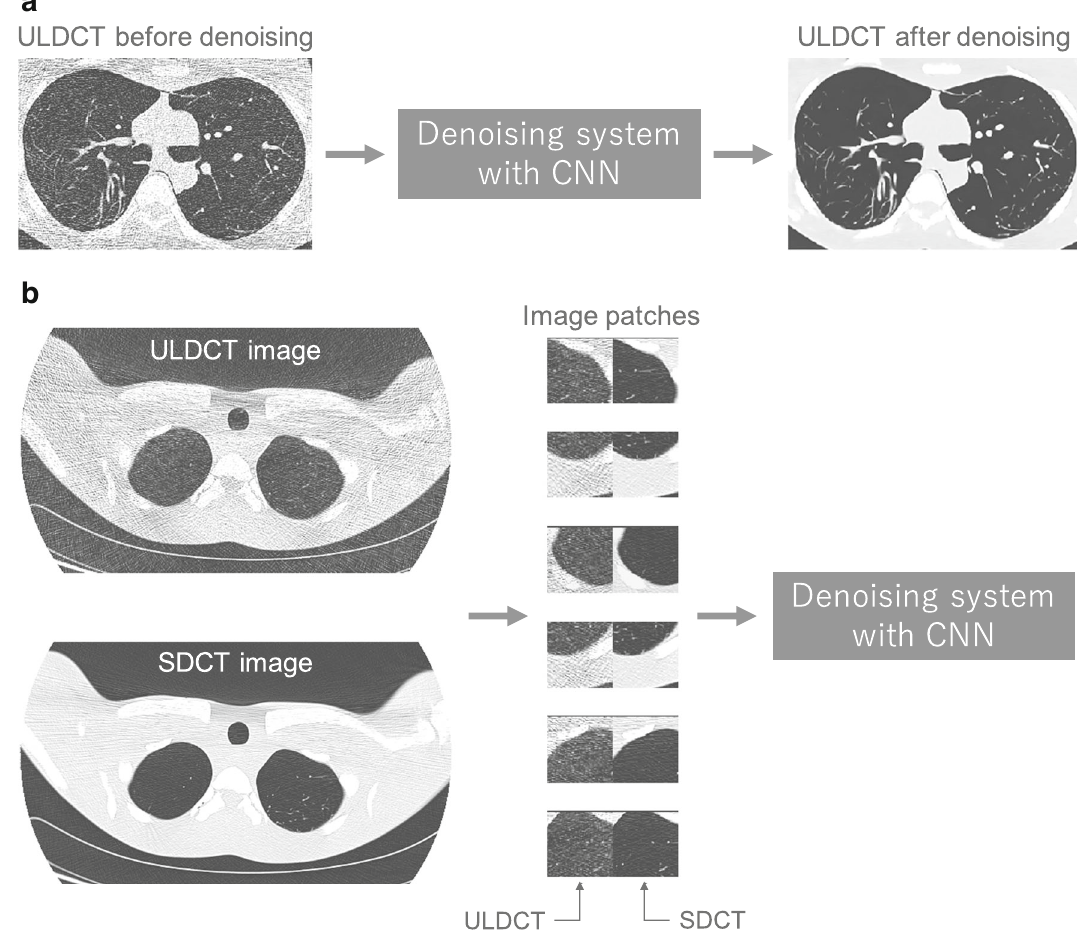
Fig. 13 A schematic illustration of the system for denoising an ultra-low-dose CT (ULDCT) image of phantom and representative examples of its training data. a Denoising system with CNN in deployment phase. b Training data used in training phase. SDCT, standard-dose